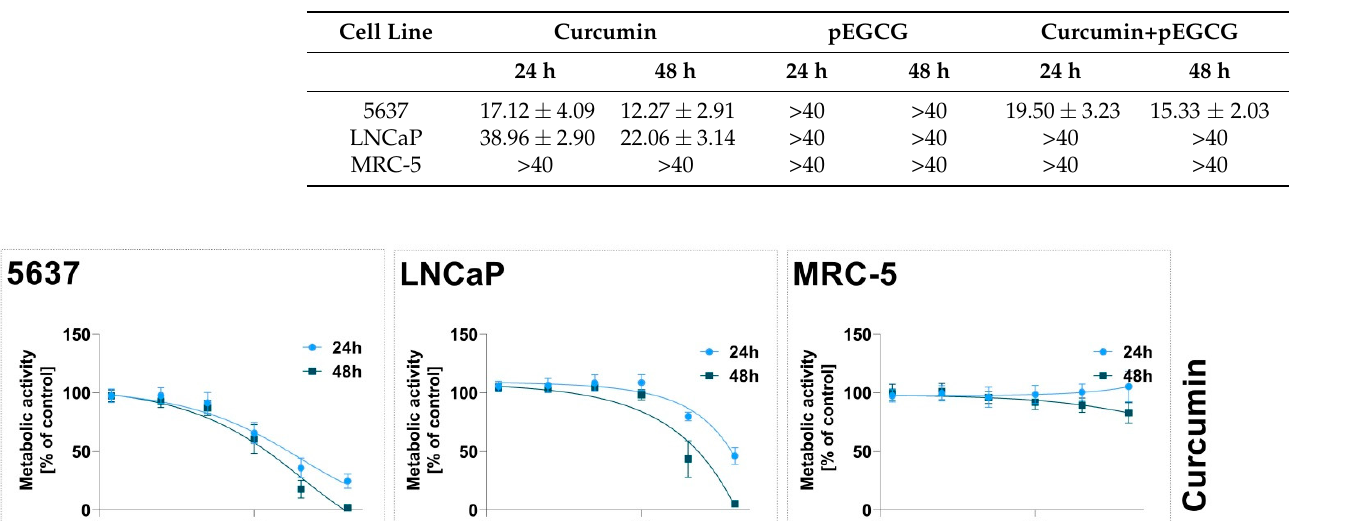
Table 6. The IC 50 values of curcumin, pEGCG, and their combination in liposomes. Data are expressed as the mean ± SD from three independent experiments.